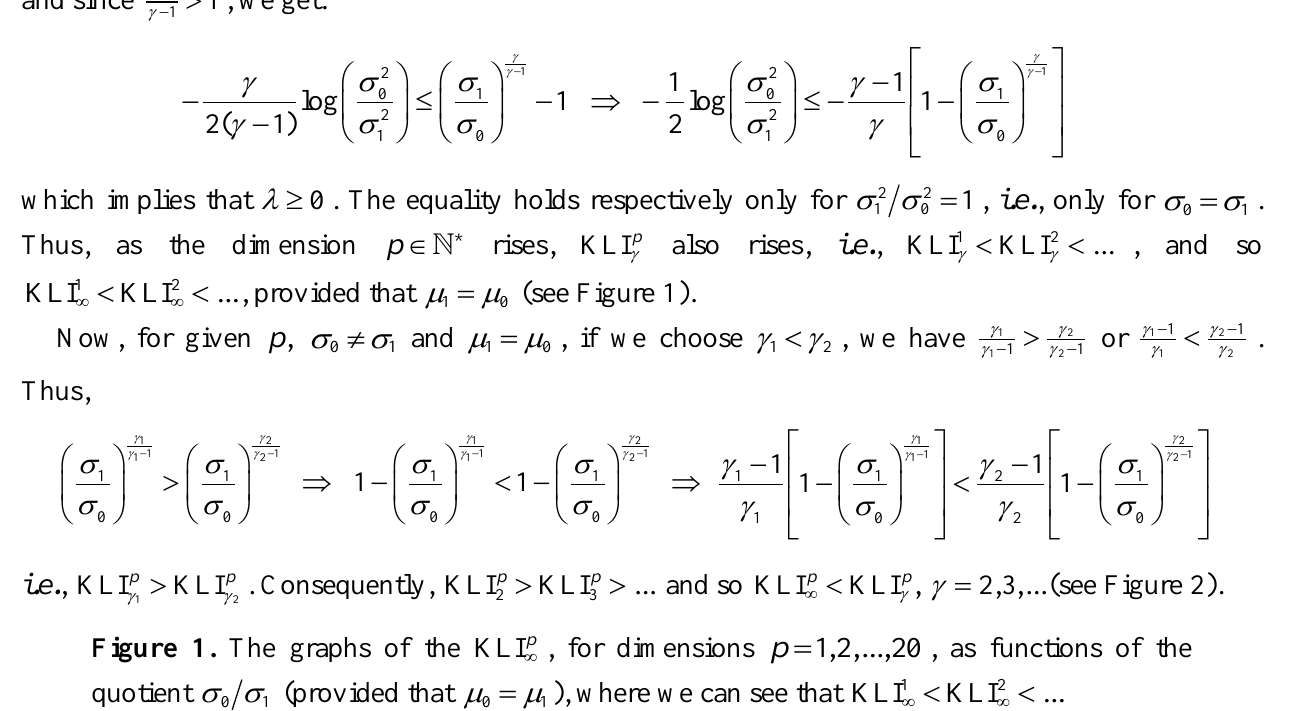
, for dimensions 1,2,...,20 p  